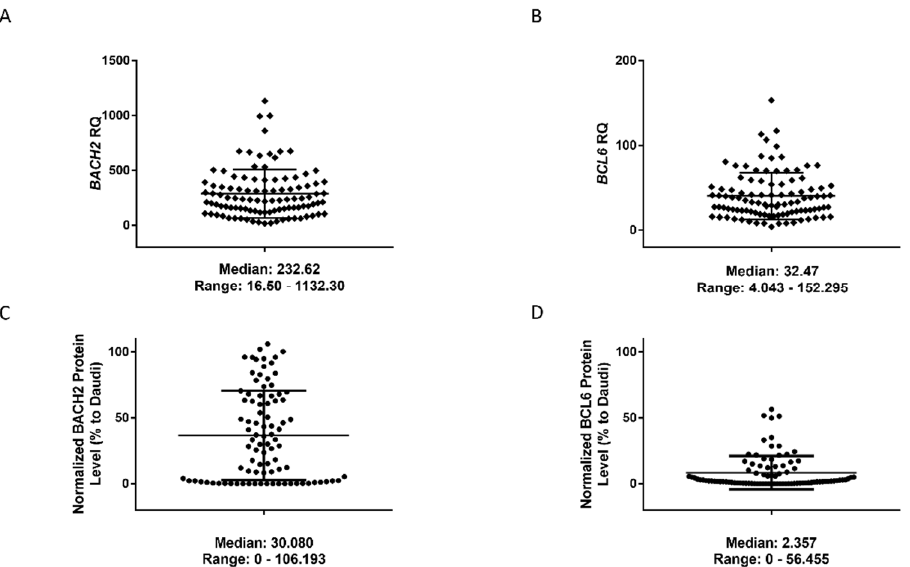
Figure 1. RNA and protein expression levels of BACH2 and BCL6 in CLL samples. Scatter plots showing BACH2 RNA levels ranging from 16-fold to 1132-fold ( A ) whereas BCL6 RNA levels range from 4-fold to 152-fold ( B ). Scatter plot showing BACH2 protein levels ranging from 0 to 106 ( C ) and BCL6 protein levels ranging from 0 to 56 ( D ).